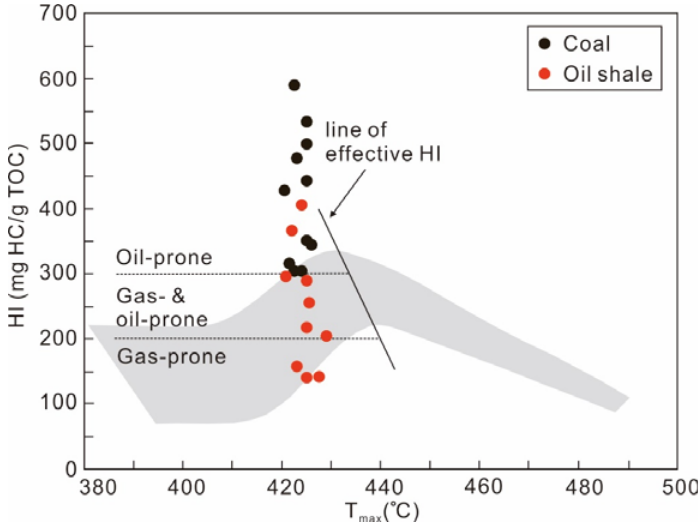
Figure 13. Modified HI-T max diagram highlighting the increase in HI prior to the onset of oil expul- sion, after [37]. The classification of kerogen quality is from